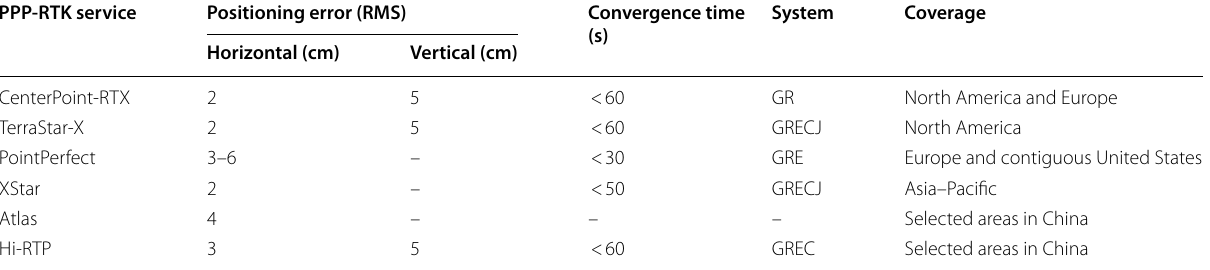
Table 5 Commercial PPP-RTK service and performance (G, R, E, C represent GPS, GLONASS, Galileo, BDS respectively) PPP‑RTK